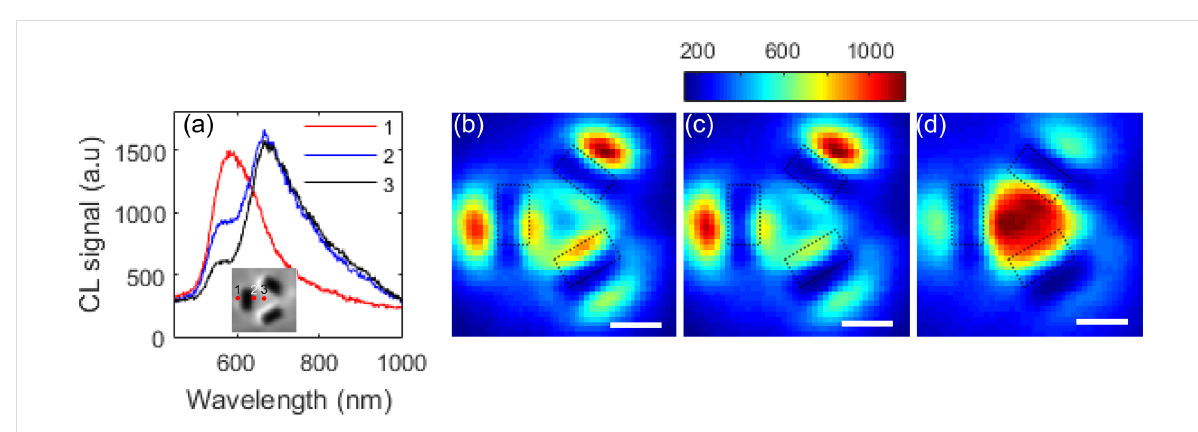
Figure 3: (a) CL spectrum from trimer slot structures with slot length 150 nm, width 65 nm and separation 100 nm obtained at different positions shown in the inset. Spatial variation of CL emission at wavelength bands (b) 550–560 nm, (c) 575–585 nm and (d) 665–675 nm. The scale bar in (b–d) is 100